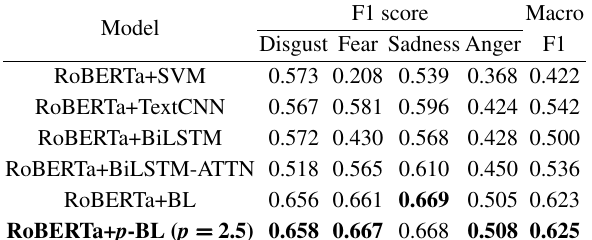
Table 7 Performance of different methods on NLPCC